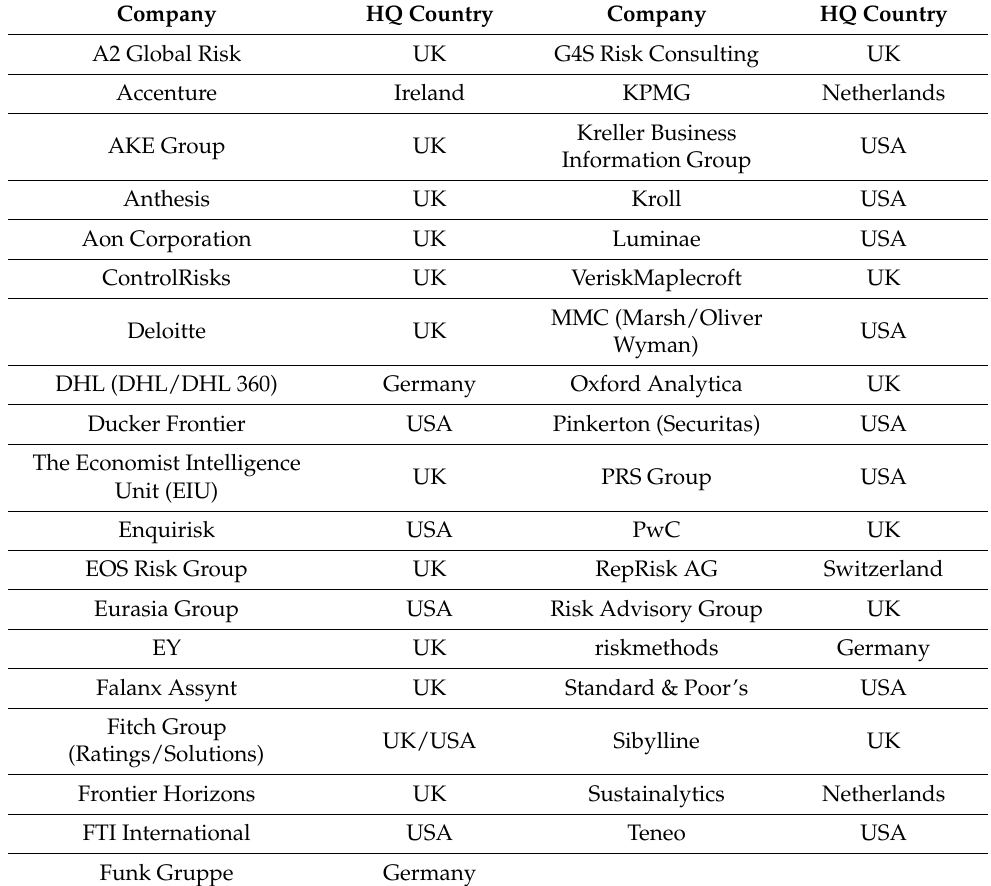
Table 1. Companies in the